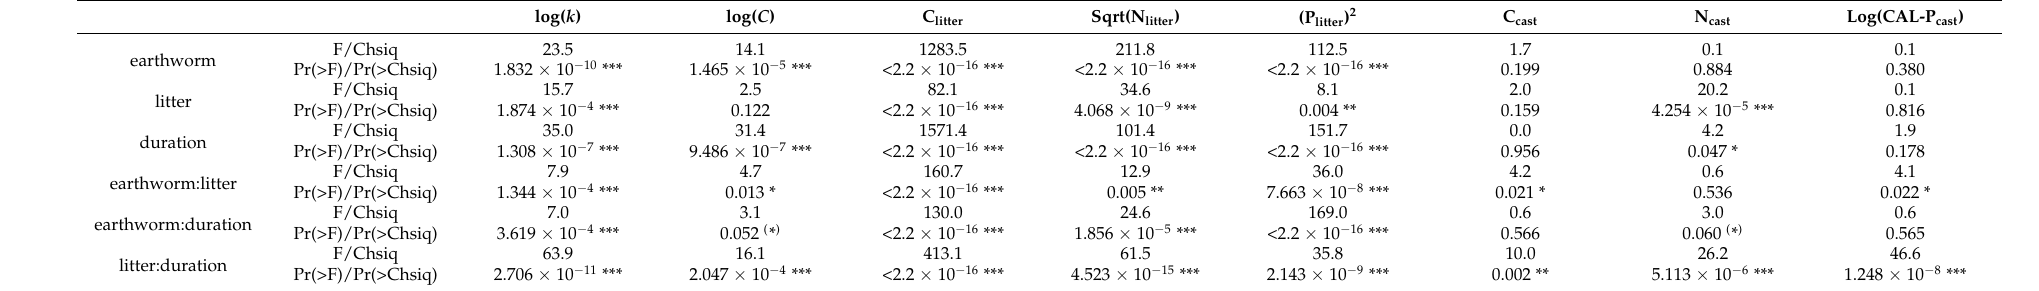
Table 3. ANOVA significance levels as expressed by F and Pr(>F) for the decomposition rate k, consumption rate C, total C, N and P released from the litter (C litter , N litter , P litter ) and total C and N and CAL-P of the casts (C cast , N cast , CAL-P cast ). Earthworm treatment, litter treatment and duration were used as dependent variables. F and Pr(>F) values for the decomposition rate k, consumption rate C and the total C and N and CAL-P of the casts (C cast , N cast , CAL-P cast ) as well as Chisq and Pr(>Chisq) values for the total C, N and P released from the litter (C litter , N litter , P litter ) are given for interaction effects of the earthworm treatment and litter treatment (earthworm:litter), earthworm treatment and duration (earthworm:duration) and litter treatment and duration (litter:duration). log( k ) log( C